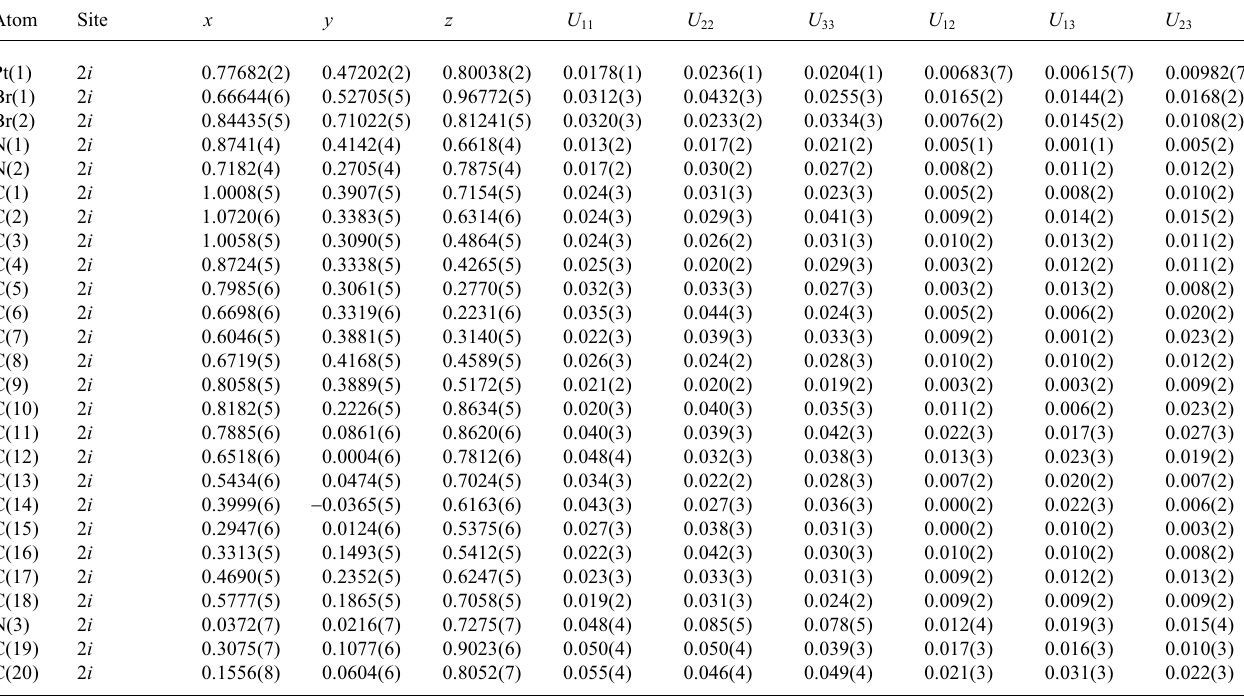
Table 3. Atomic coordinates and displacement parameters (in Å 2 )